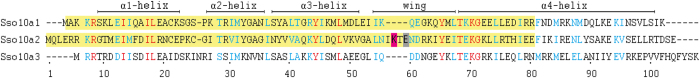
Amino acid sequence alignment of Sso10a1 (SSO10449), Sso10a2 (SSO2827) and Sso10a3 (SSO2986).Sequence alignment was performed using the Clustal Omega program59. Secondary structure elements are indicated based on the Sso10a1 structure. Identical residues are indicated in red and conserved residues are indicated in cyan. The DNA binding domains Sso10a1_DBD and Sso10a2_DBD are highlighted in yellow. Residues K57 and E59 of Sso10a2 are highlighted in magenta and grey respectively.